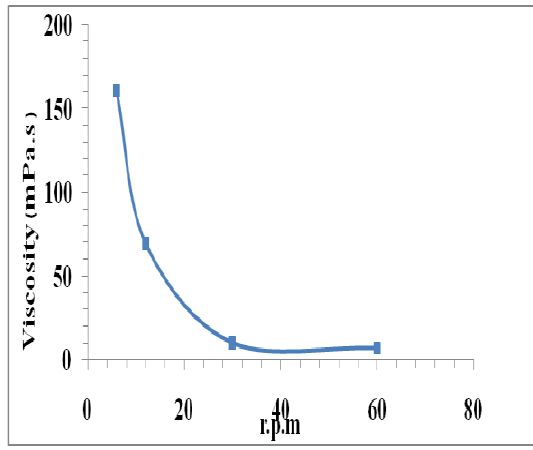
Figure (3): Viscosity versus rpm at 37 0 C for F . 3